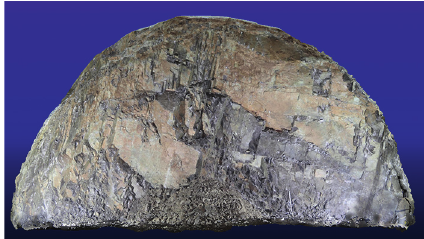
Figure 13: The final result after 3D reconstruction.